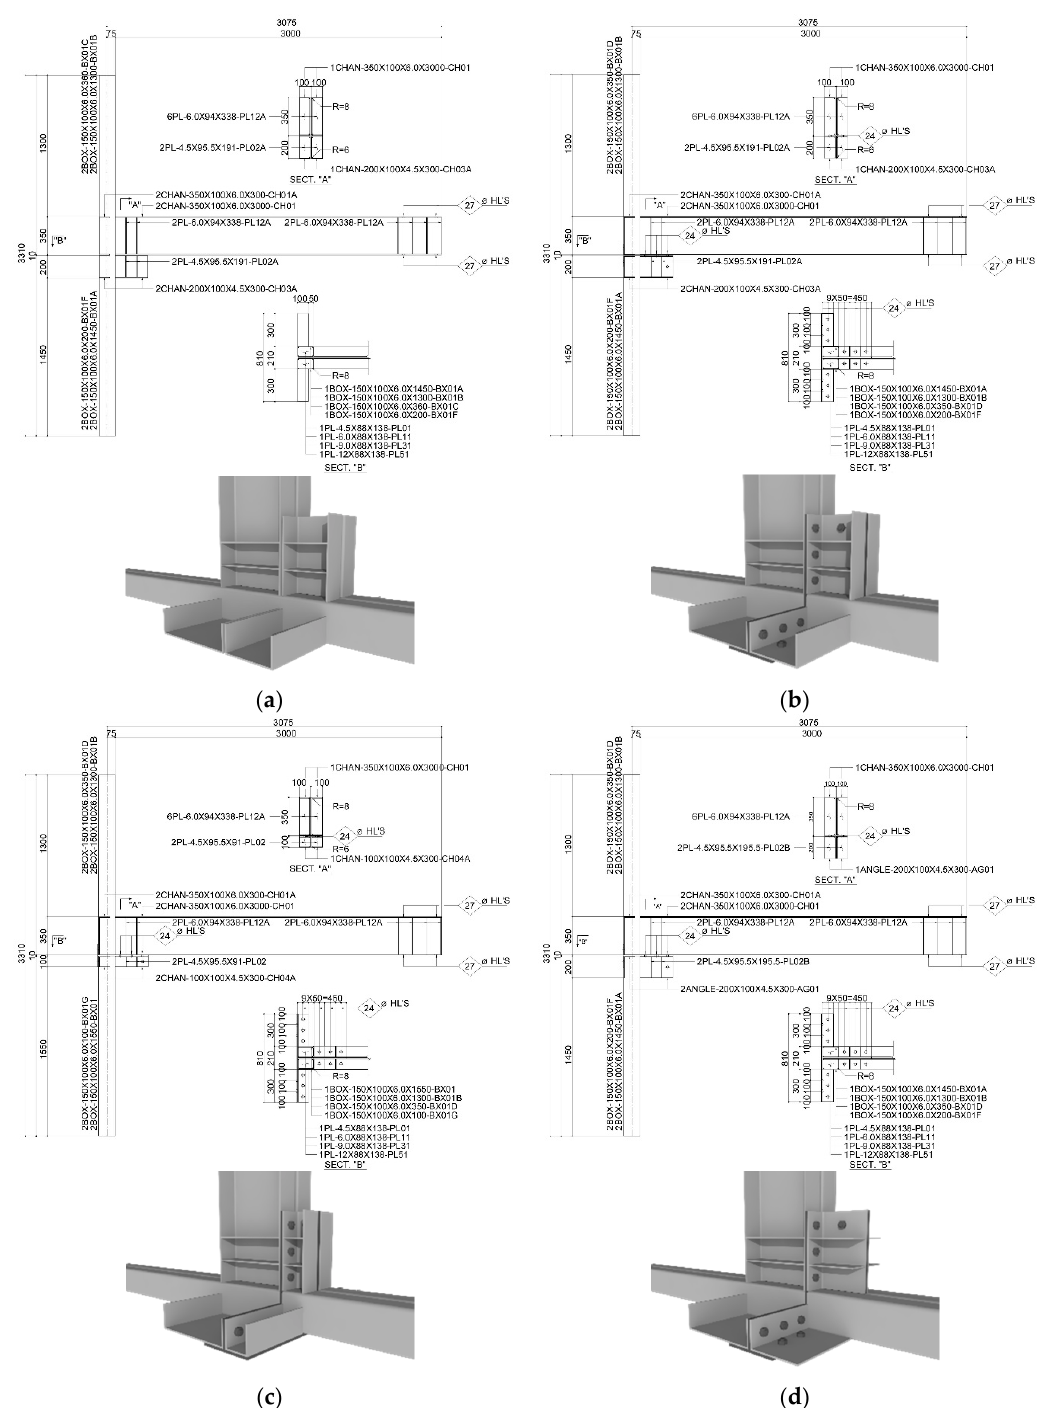
Figure 3. Details of the test specimens. ( a ) C200-W; ( b ) C200-B; ( c ) C100-B; ( d ) L200-B.